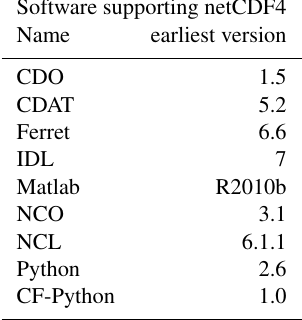
Table A2. Table of software products that support netCDF4. Listed are the software packages and the earliest version of that software that supports